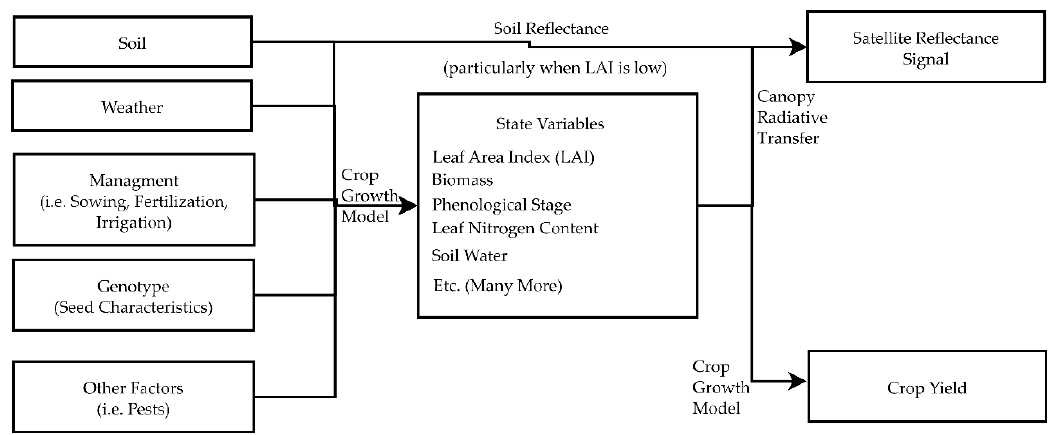
Figure 1. Interrelationships among yield, satellite measurements, crop state variables and G × E × M factors.